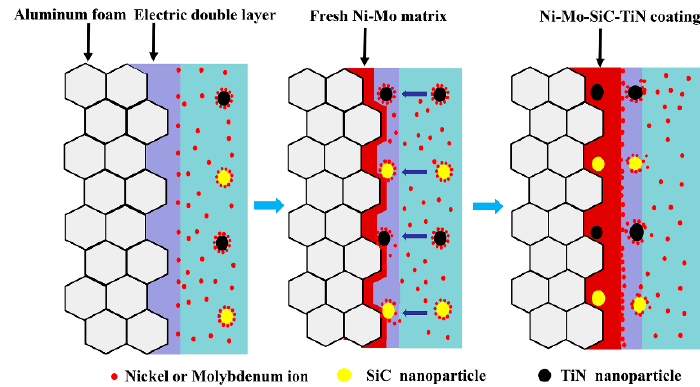
Figure 1. A schematic diagram representing the electrodeposition process of a duplex nanoparticles reinforced Ni–Mo